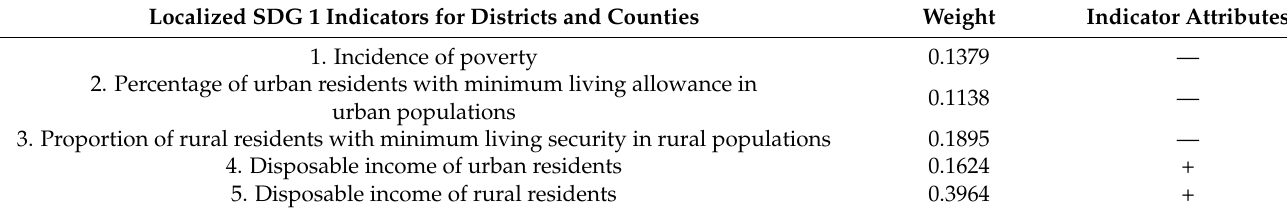
Table 2. Localized, SDG 1 index weight for districts and counties.